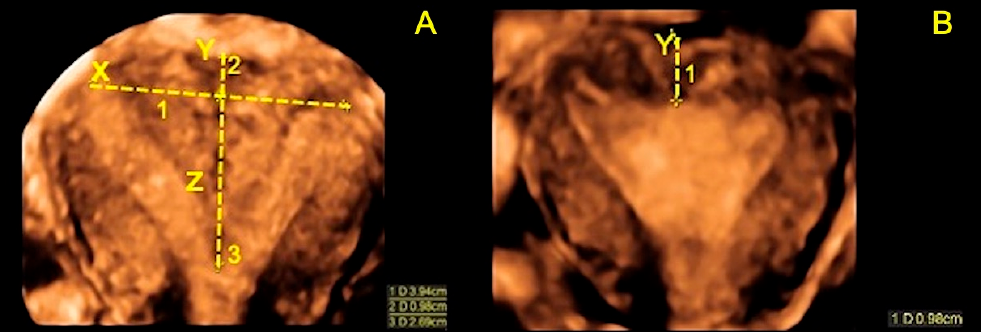
Figure 2. Ultrasound images of a complete septate uterus (U2b according to ESHRE/ ESGE) before and after surgery. ( A ) Ultrasound midcoronal view of the complete septate uterus before hysteroscopic metroplasty with all the measurements of the septum (the uterine wall thickness (Y), the base of the septum (X) and the length of the septum (Z)); ( B ) Ultrasound midcoronal view of the same uterus three hours after surgery. The fundal uterine wall thickness is 1 cm, confirming the complete incision of the septum.